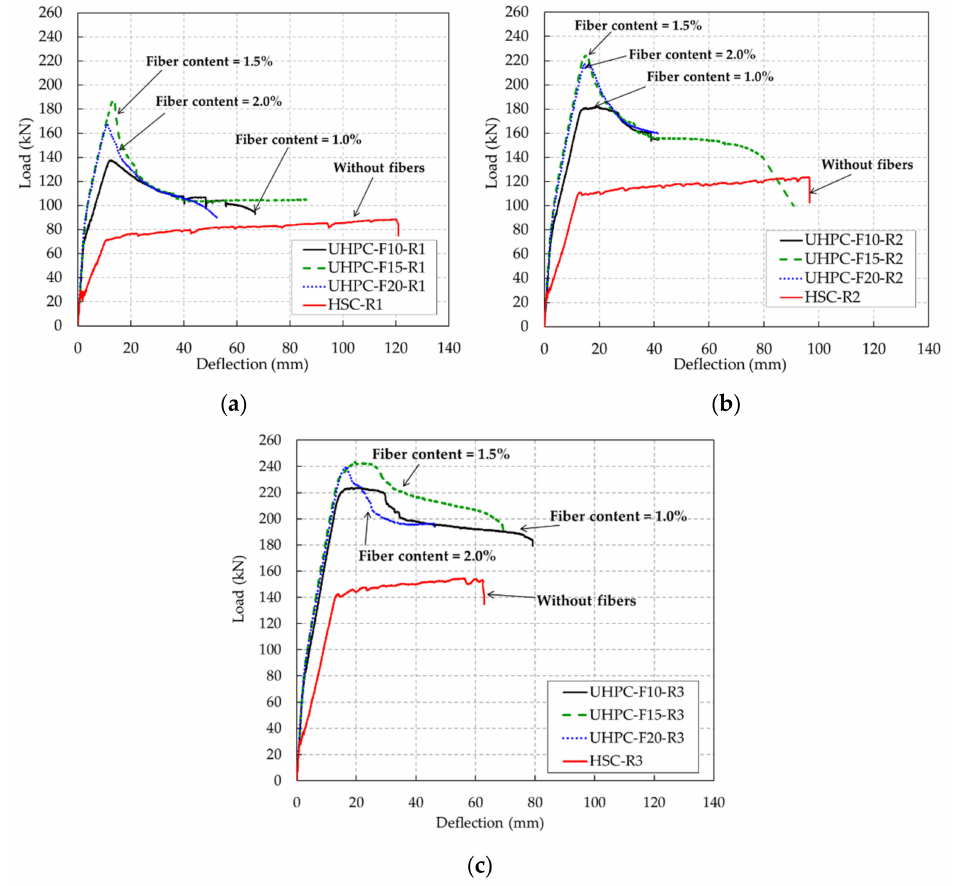
Figure 13. Comparison of the load-deflection relationships of the UHPC and HSC beams. ( a ) R1 series beams (rebar ratio of 0.79%), ( b ) R2 series beams (rebar ratio of 1.18%), ( c ) R3 series beams (rebar ratio of